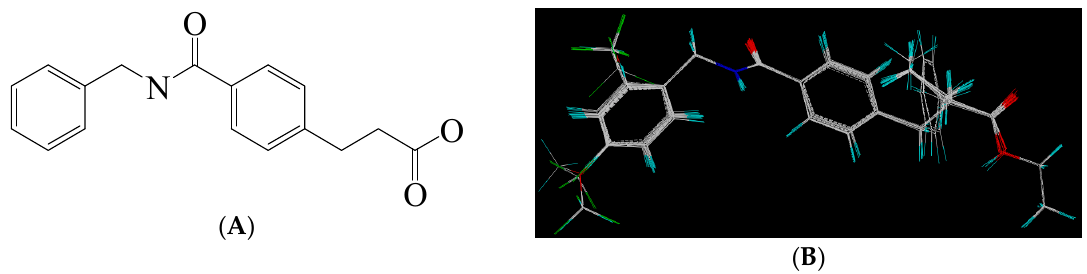
Figure 5. Molecular alignment. ( A ) Common structure retrieved from compound 24 ; ( B ) Alignment of the compounds in the training set.